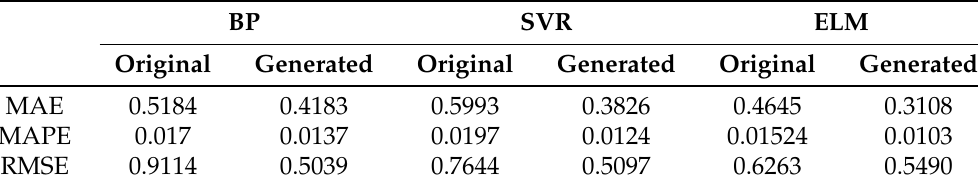
Table 2. Comparison of setting errors of water